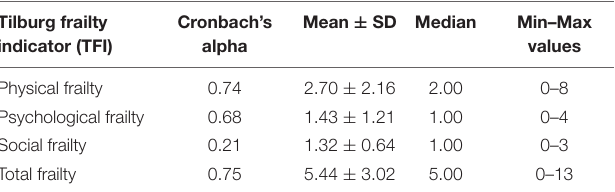
TABLE 2 | Frailty levels of the older adults.